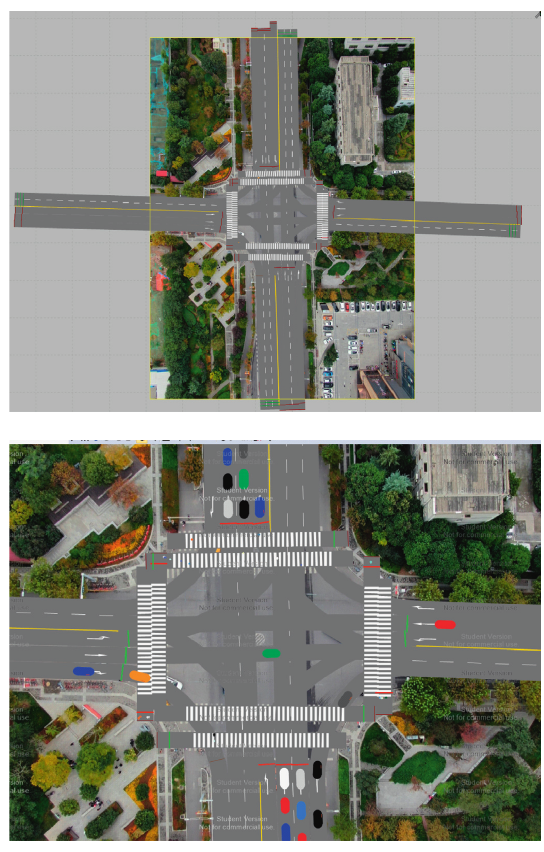
Figure 4: Simulation interface and operation diagram. Table 3: Pedestrian crossing speed Table 2: Simulation results of the original scheme. Simulation time